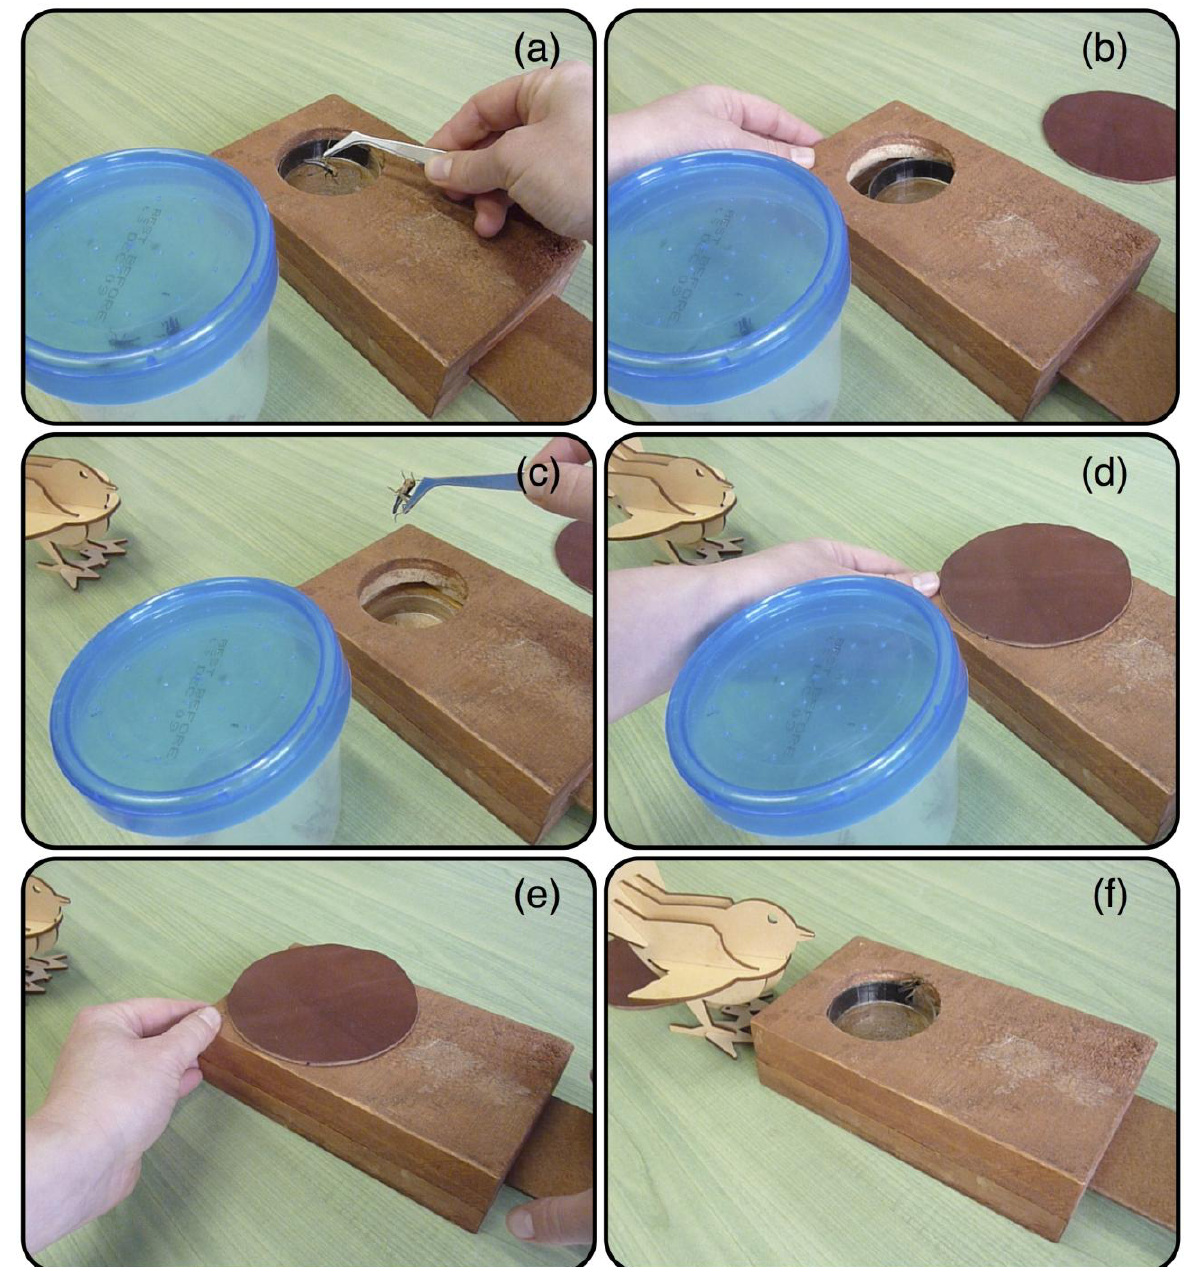
Figure 1 . The VoE apparatus: Out of view of the bird, in the upper compartment, (a) insects are placed inside and (b) the compartment is slid out, hiding it. In view of the bird, in the lower compartment (c) insects are placed inside (d) the lid covers the well, (e) the drawer is slid in, and (f) the bird allowed to access the upper